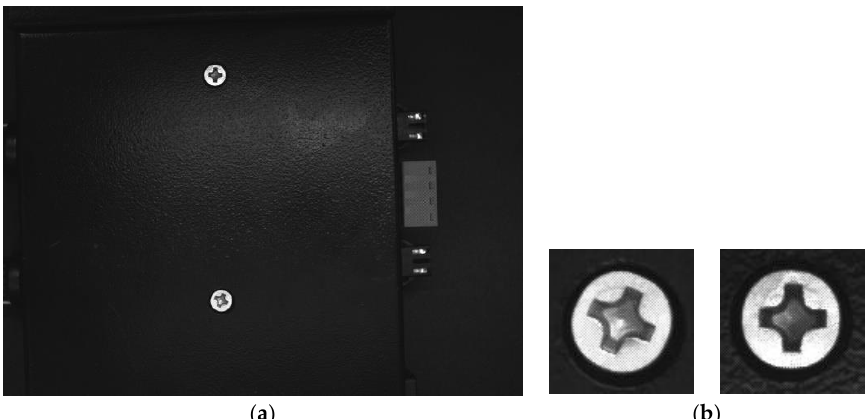
Figure 2. Data acquisition. ( a ) Original image, ( b ) Detected screws.